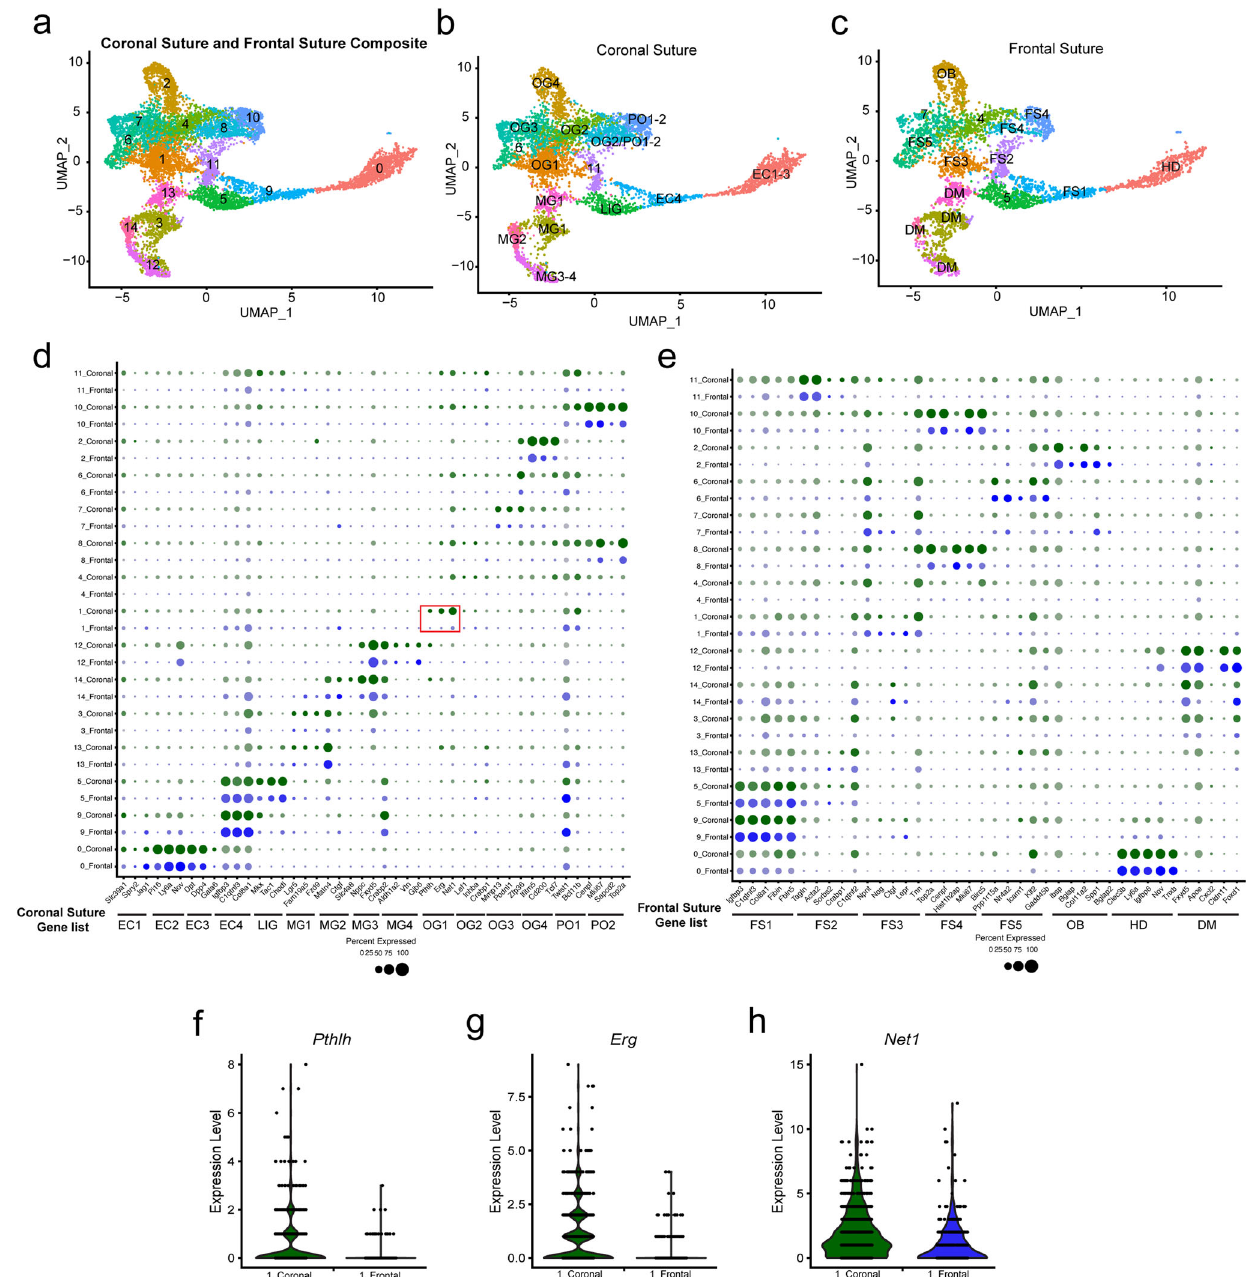
Fig. 6 Comparison of frontal and coronal datasets. a UMAP analysis of osteogenic and mesenchymal cells from integrated E17.5 coronal and E18.5 frontal datasets. b , c Cell clusters separated by suture type and labeled with respective names. d , e Dot plot showing the intersection of cluster markers from the coronal suture datasets (Fig. 1g) and for the frontal suture datasets from Holmes et al. 30 , mapped onto to integrated dataset split by suture. Red box labels OG1 markers. f – h Violin plots highlight enriched expression of OG1 markers Pthlh , Erg , Net1 in cluster 1 cells from the coronal versus frontal